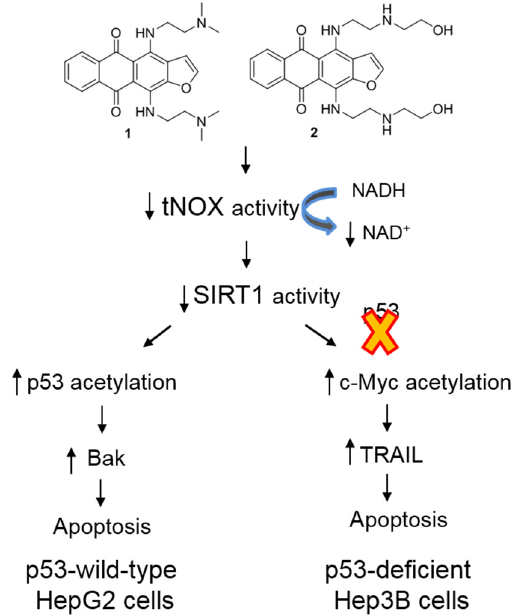
Figure 8. Schematic diagram of the pathways that lead to the different pathways of p53-wild-type HepG2 and p53-deficient Hep3B cells by 4,11-diaminoanthra[2,3- b ]furan-5,10-diones 1 and 2 .